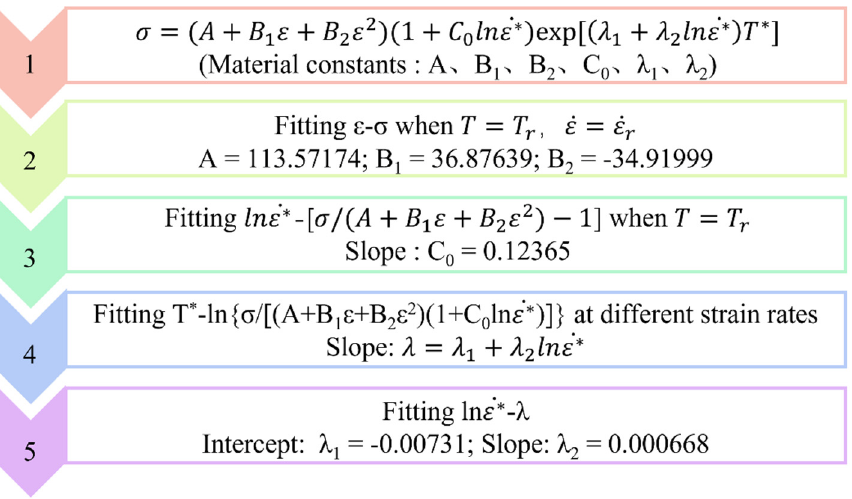
Figure 7. Flow chart for solving MJC model parameters. Ye et al. [20] pointed out that the reference strain rate of MJC is generally chosen from 0.1~0.001 s − 1 , and in this paper, 0.1 s − 1 was chosen as the reference rate i.e., and 350 ◦ C as the reference temperature i.e., T r = 623.15 K. Equation (8) was obtained . . ε = ε r . Fitting the ε - σ curve with a quadratic polynomial, as shown in when T = T r , and Figure 8a, yielded A = 113.57174, B 1 = 36.87639, and B 2 = −